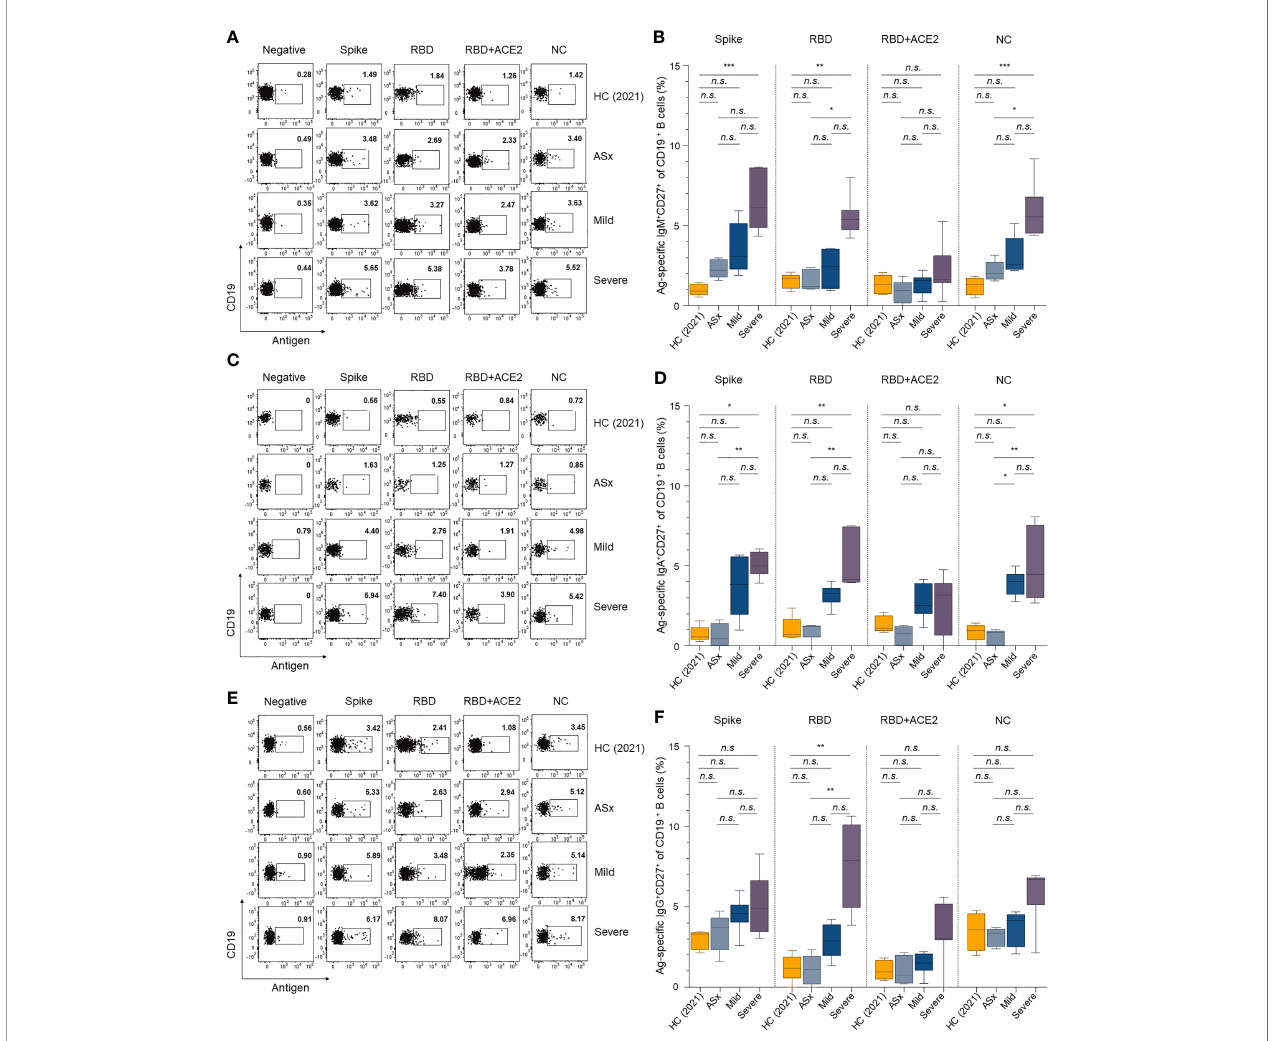
FIGURE 3 | Memory B-cell responses against SARS-CoV-2 according to the severity of illness. (A, C, E) Representative gating strategy for IgM + , IgA + , and IgG + antigen-speci fi c memory (CD27 + CD19 + ) B cells. (B, D, F) Frequencies of IgM + , IgA + , and IgG + antigen-speci fi c memory B cells according to the severity of illness and different antigens. Statistical analysis was performed using the Kruskal – Wallis rank-sum test with Dunn ’ s post hoc test in GraphPad Prism ( n.s .: P > 0.05, * P < 0.05, ** P < 0.01, *** P <